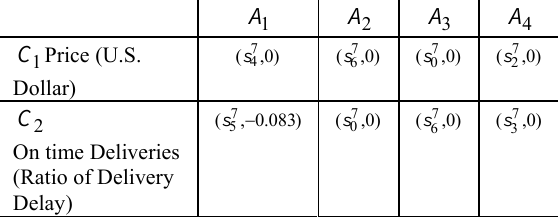
Table 5. Linguistic variable of quantitative information